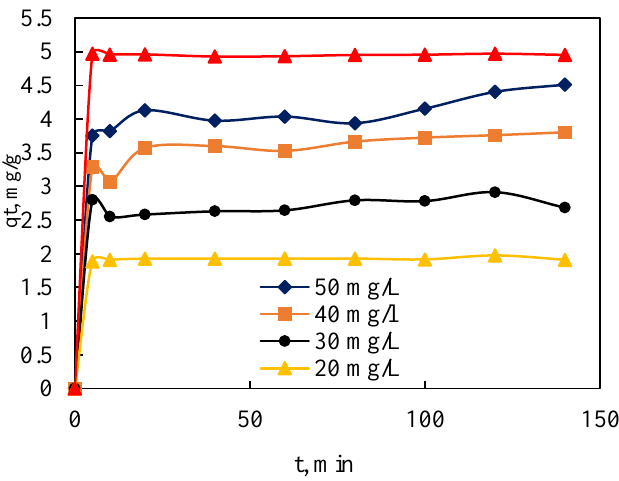
Fig. 5 Kinetic study on various initial concentration of MB Table 3. Kinetic parameters of pseudo 1 st order and pseudo 2 nd order